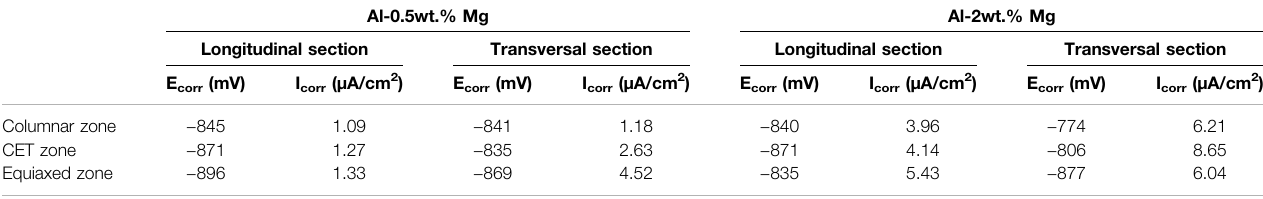
TABLE 2 | Fitting corrosion potentials, E corr , and corrosion current density, I corr , of Al-Mg alloys in 0.5 M NaCl. Al-0.5wt.% Mg